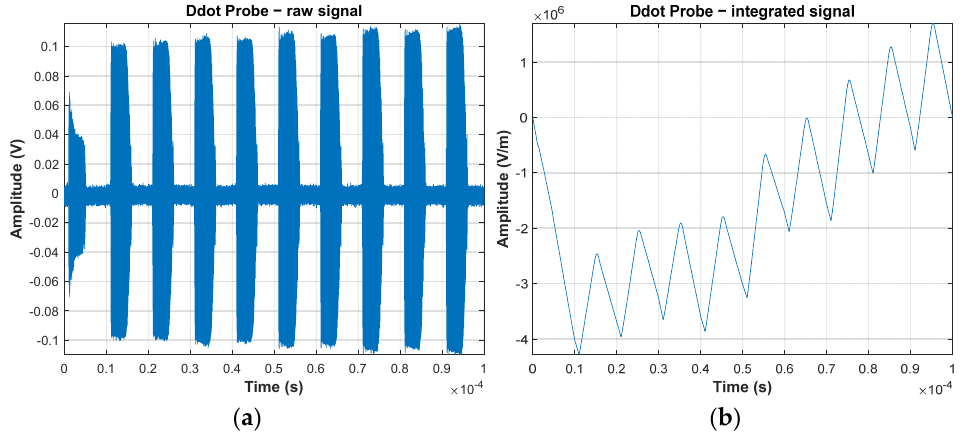
Figure 13. Sample HPM sinusoidal packets registration ( a ), together with initial integration ( b ).